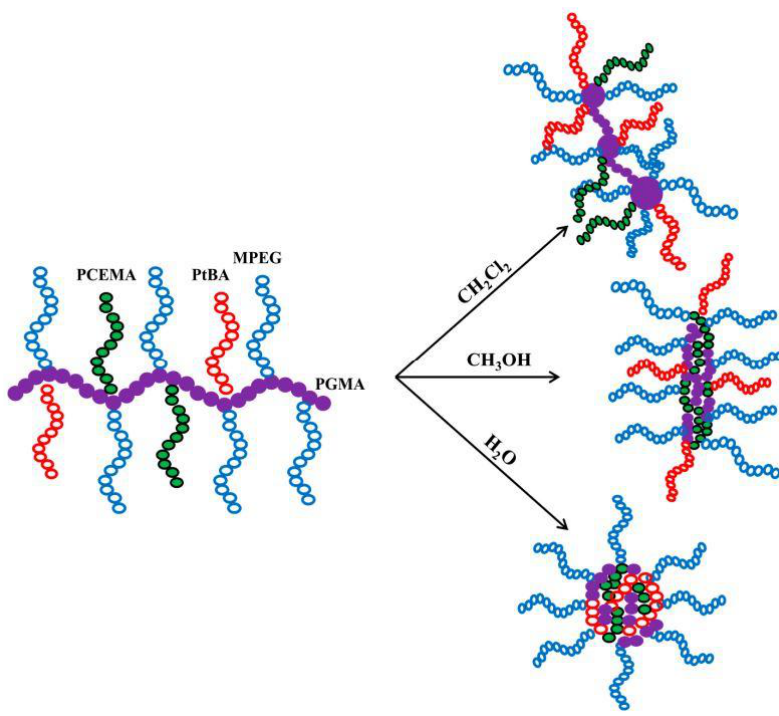
Figure 11. Micellar conformation of PGMA- g -(PCEMA-PtBA-MPEG) copolymers in CH 2 Cl 2 , CH 3 OH and H 2 O selective solvents, respectively. Adapted from Mo et al. [117].